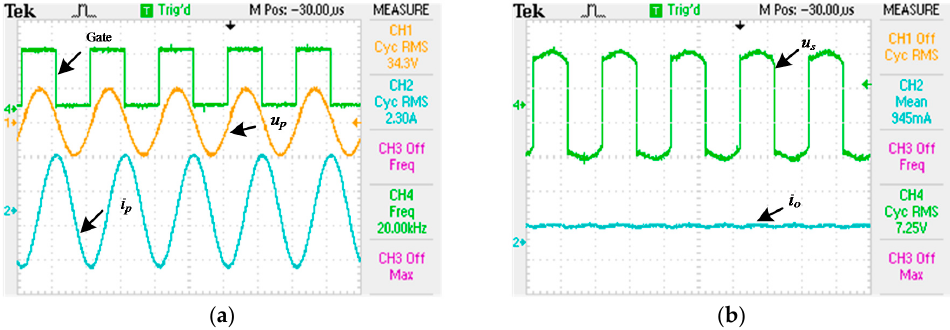
Figure 13. The experimental results of the WPT system: ( a ) Waveform of the primary coil in WPT system; ( b ) Waveform of load in WPT system.